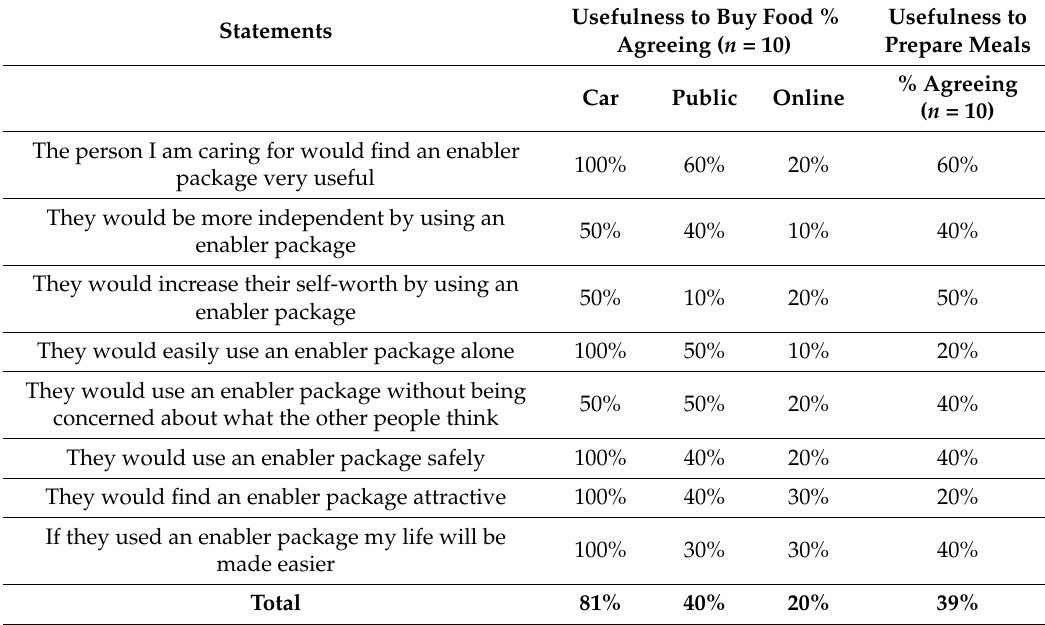
Table 6. Overall opinions on enabler packages ( n =